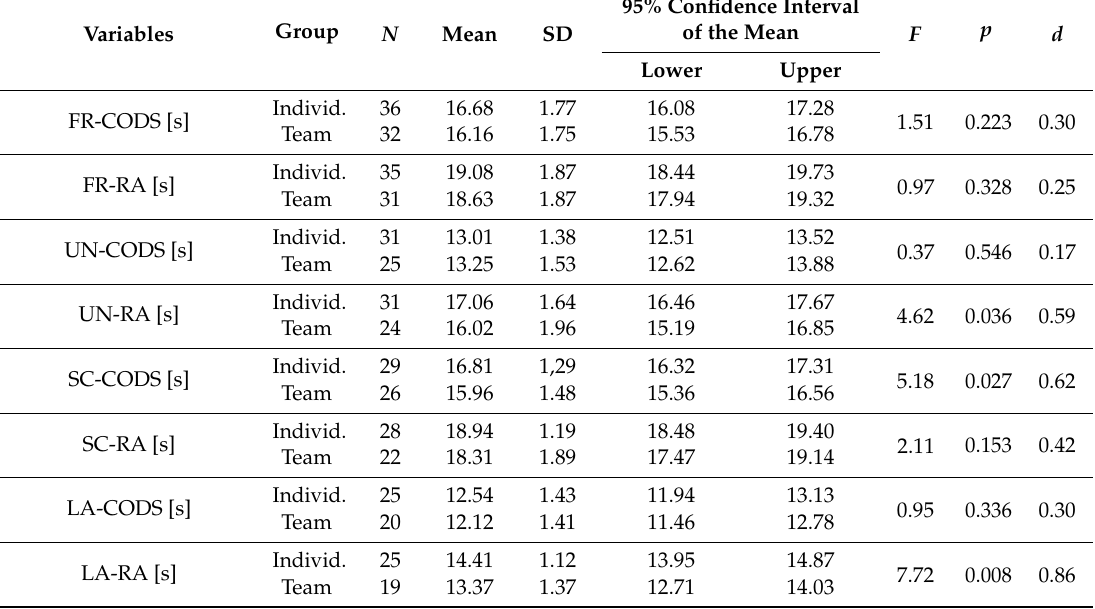
95% Confidence Interval of the Mean F p d Lower Upper